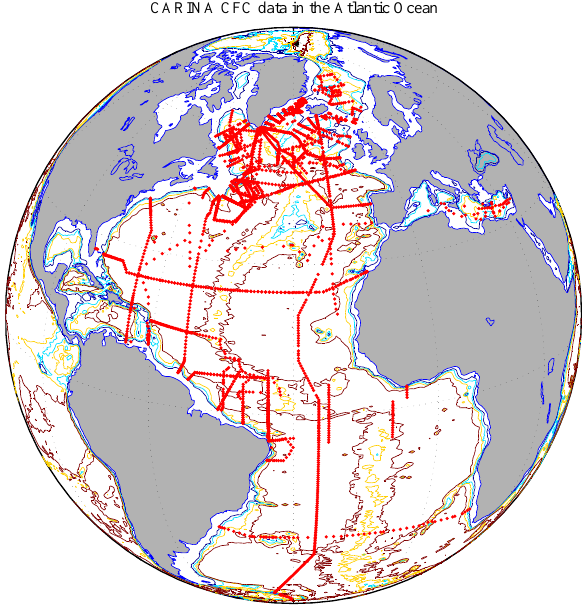
Figure 1 Figure 1. Map of the positions of all stations with at least one CFC measurement in the CARINA dataset for the Atlantic